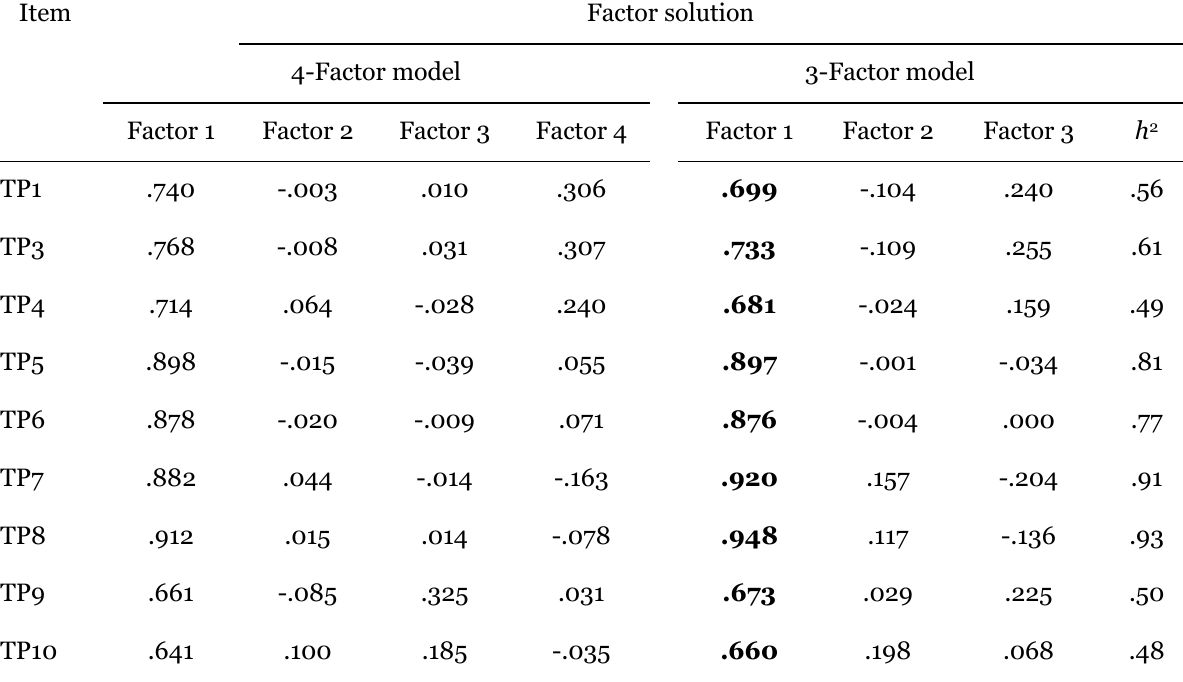
Factor Loadings for the Three- and Four-Factor Solutions